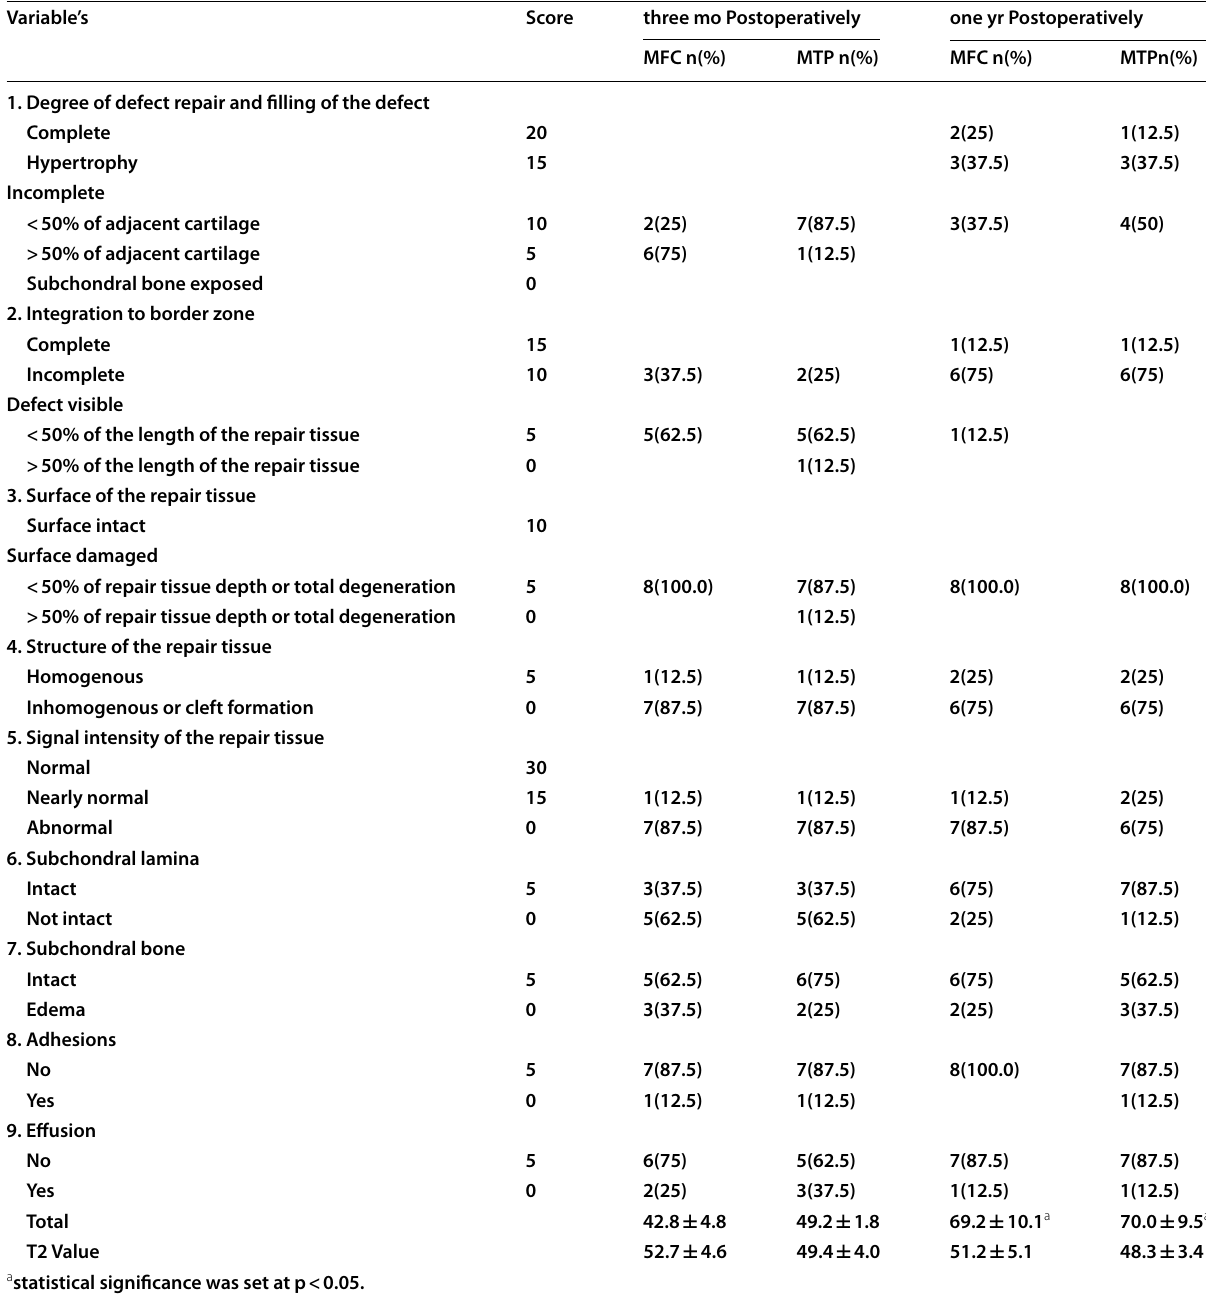
Table 3 MOCART scores and T2 values of the repaired